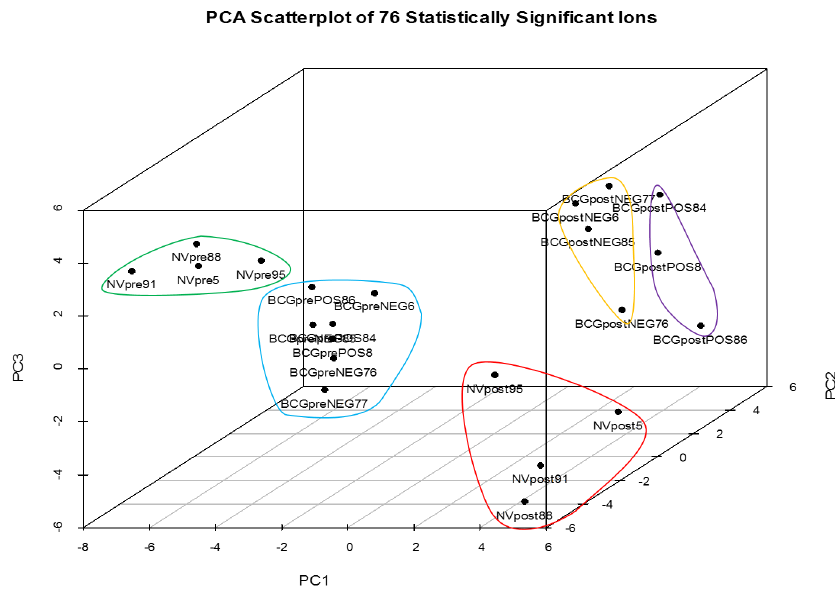
Fig 1. Principal component analysis three dimensional scatterplot of 76 ions. Pre-challenge non- vaccinated (NVpre) and BCG-vaccinated (BCGpreNEG; BCGprePOS) sample groupsare indicatedby green and blue circles, respectively. Post-challenge virulent M . bovis positive non-vaccinated (NVpost) and BCG- vaccinated (BCGpostPOS), and virulent M . bovis negative BCG-vaccinated(BCGpostNEG) sample groups are indicatedby red, orange, and purplecircles, respectively. Pre- and post-challenge sample groups are separatewithin the three dimensional space, indicatingthat pre-challengeand post-challenge calves are different. Pre-challenge sample groups (NVpre; combinedBCGprePOS, BCGpreNEG) are separate indicating that these sample groups are distinctly different from each other. Post-challenge sample groups are separateand distinct, indicatingthat these sample groupsare different. Within each sample group, individual samples appearcloselyassociatedwith each other indicating that intra-group samples are similar to each